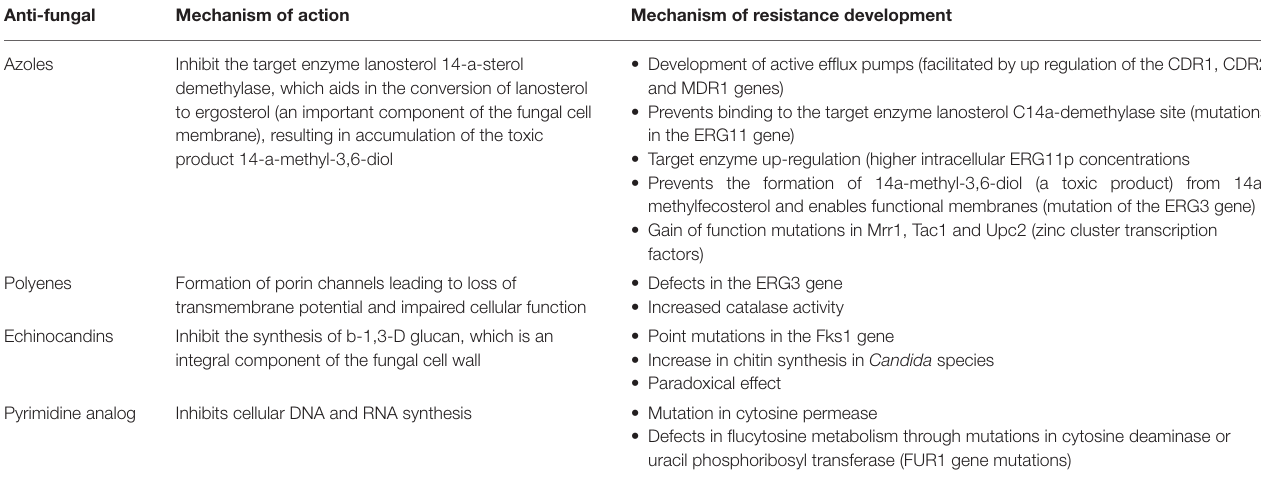
TABLE 3 | Major classes of anti-fungal drugs and mechanism of resistance in Candida species (Kanafani and Perfect, 2008; Pfaller, 2012; Vandeputte et al., 2012; Morace et al., 2014; Patil et al., 2015; Sanguinetti et al., 2015; Sanglard, 2016; Hampe et al., 2017 ).